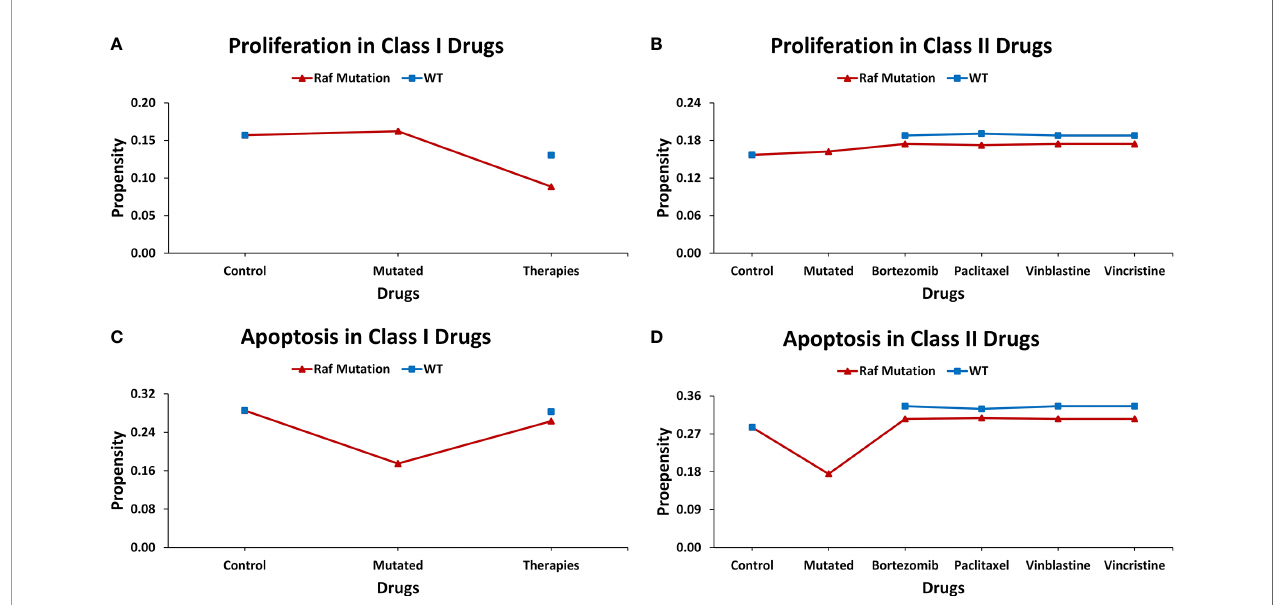
FIGURE 5 | Evaluating cell fates under therapeutic screens taken from Markstein et al. ‘ s Drosophila model. (A) The effect of class I drugs on cell proliferation in wild type and mutated networks, (B) The effect of class II drugs on cell proliferation in wild type and mutated networks, (C) The effect of class I drugs on apoptosis in wild